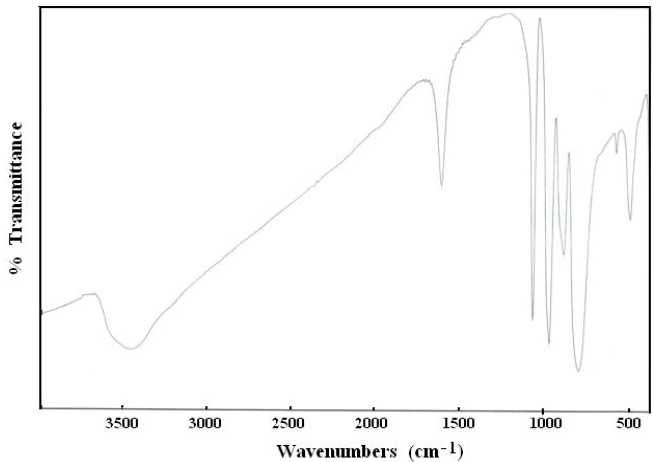
PW O Keggin-type 1.5 12 40